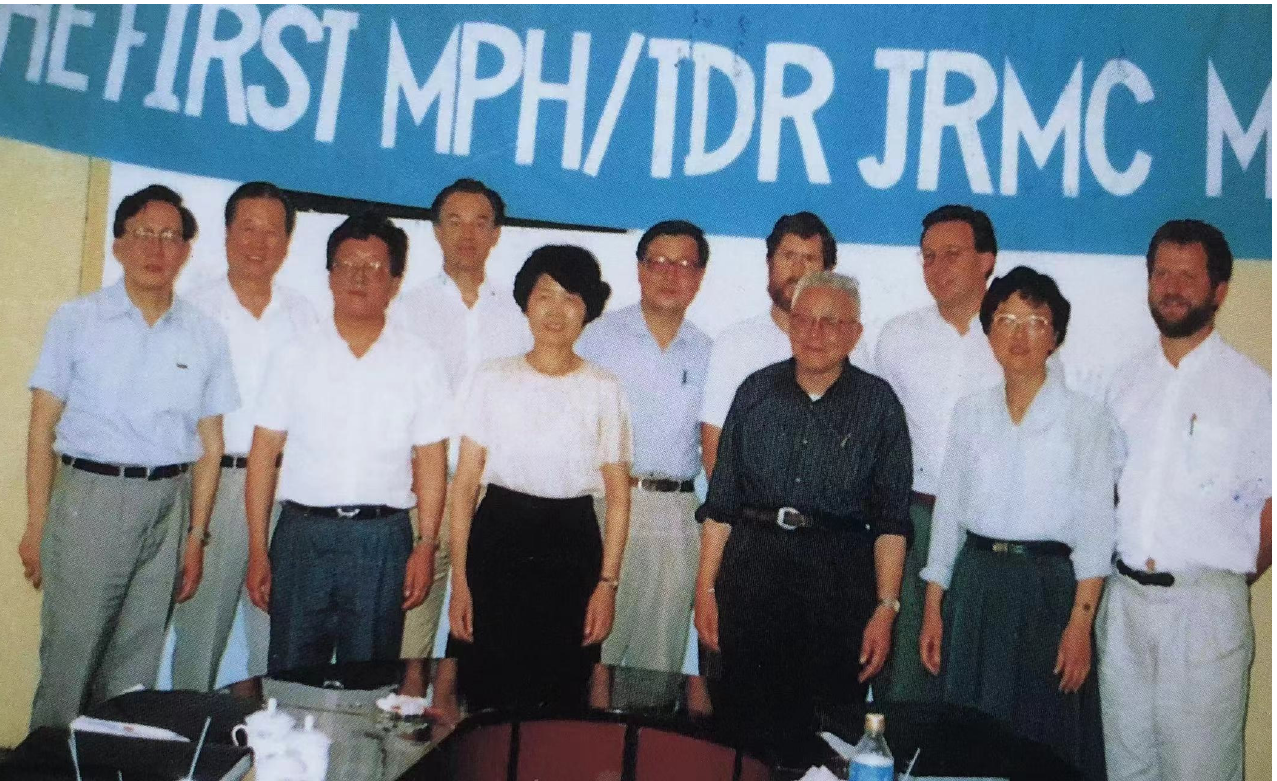
Figure 1. The first board meeting of the Joint Research Management Committee in Yueyang, China in 1992. From left to right: Drs. Minggang Chen, Hongchang Yuan, Jiang Zheng, Robert Bergquist, Qingsi Zheng, Huanzeng Wang, David Evans, Ke Qian, Marcel Tanner, Jie Chen, Bruno Gryseels .